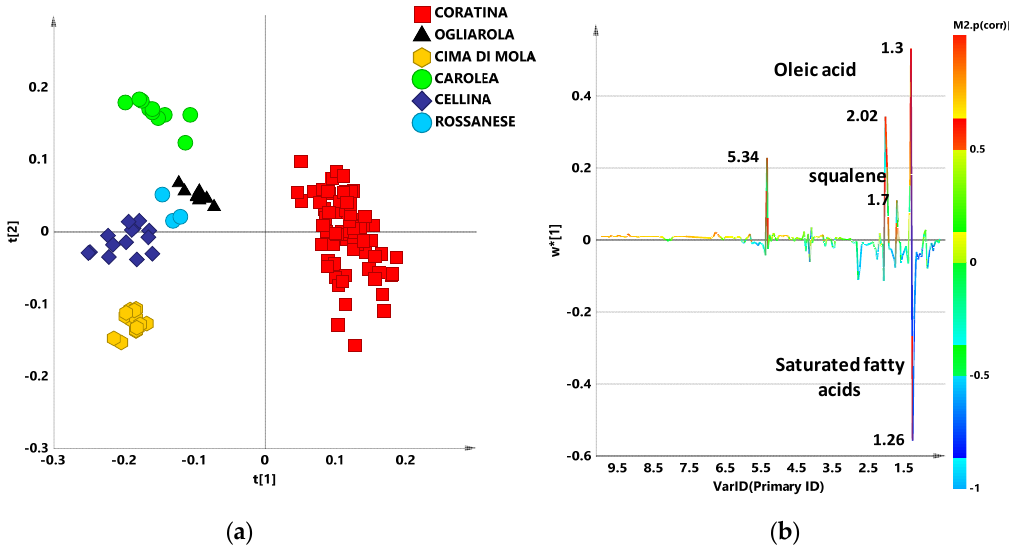
Figure 1. ( a ) Partial least squares discriminant analysis (PLS-DA) t[1]/t[2] scores plot for the monocultivar extra virgin olive oils (EVOOs) data sets. 6 components, R 2 X = 0.953; R 2 Y = 0.750; Q 2 = 0.711. ( b ) Line plot for the model, indicating the 1 H Nuclear Magnetic Resonance chemical shifts of the signals, characteristic of specific metabolites, discriminating the classes along t[1] and colored according to the correlation-scaled loading (*p(corr) ≥ |0.5|). w*c[1] axis represented the weighted correlation